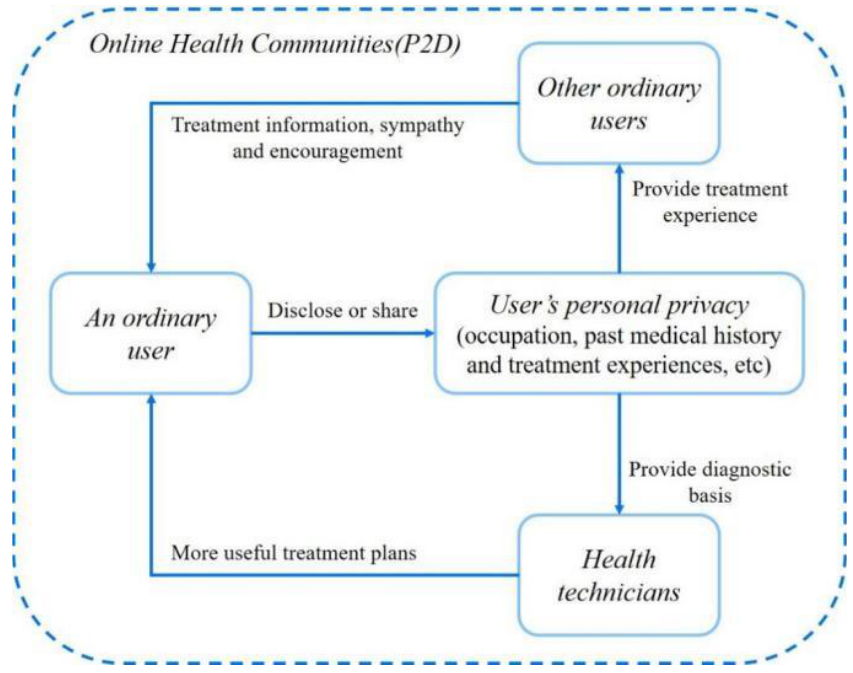
Figure 2. User privacy disclosure behavior in online health communities (P2D).